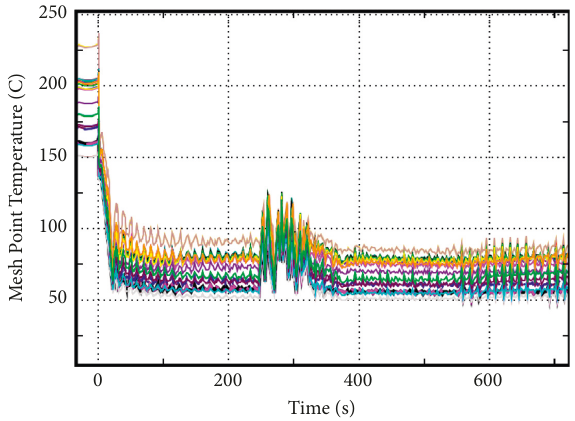
Figure 13: Dynamics of changes in the temperature of fuel ele- ments in various calculated sections of the core during the tran- sition from forced circulation to